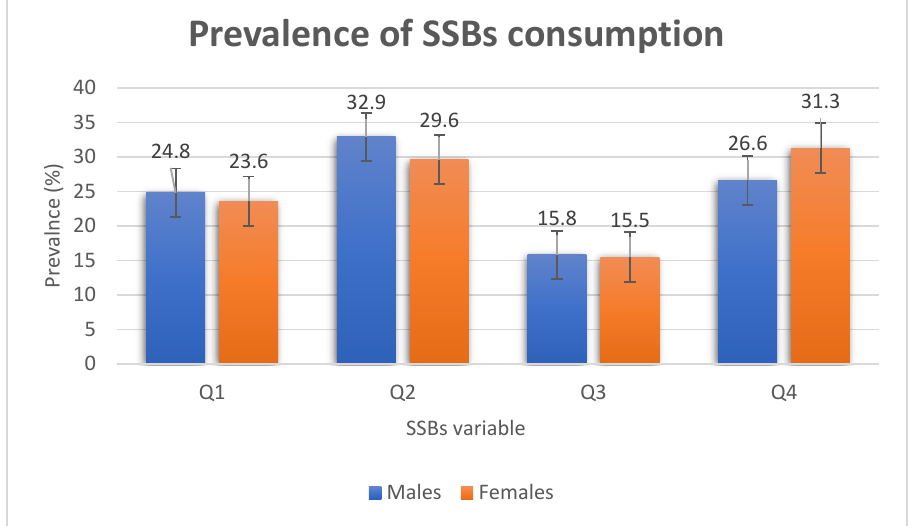
Figure 1. The prevalence of SSBs consumption was stratified by quartile among Ellisras young rural adults aged 22 – 30 years.